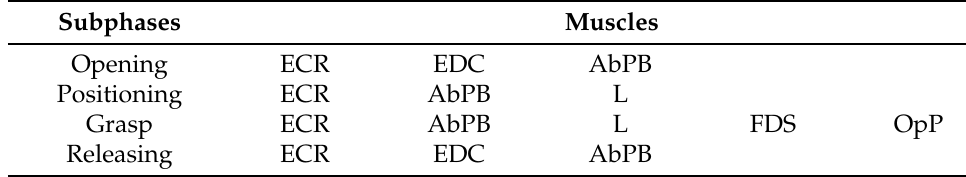
Table 1. Stimulation sequence for palmar grasping.